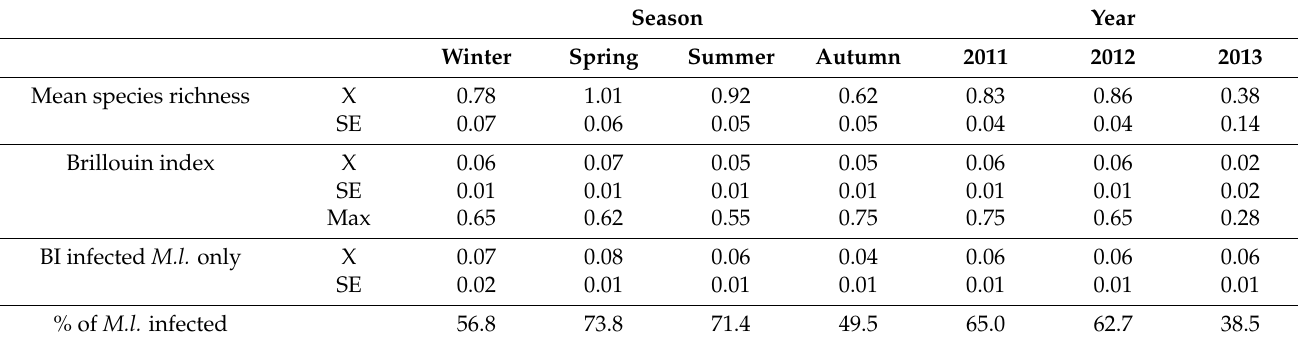
Table 12. Diversity characteristics of helminth infracommunities of Microtus lusitanicus ( M.l. ) from Asturias by season and year of capture. SE—standard